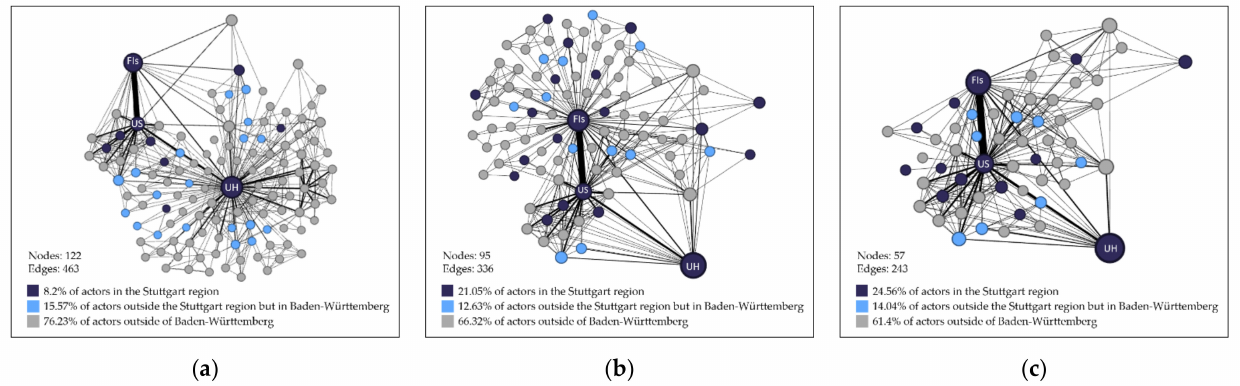
Figure 9. Ego networks of the three most central actors: ( a ) ego-network of the University of Hohenheim (UH) ( b ) ego-network of the Fraunhofer institutes (FIs); ( c ) ego-network of the University of Stuttgart (US).